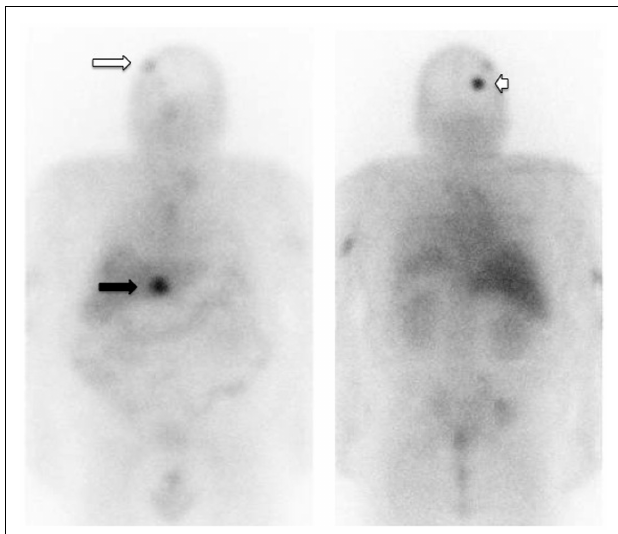
FIGURE 2 | Immunoscintigraphy (anterior and posterior views) recorded in a patient with metastatic medullary thyroid carcinoma . This patient was injected with the anti-CEA hMN14x734 bispecific antibody and a therapeutic activity of 131I-di-DTPA-indium.The immunoscintigraphy recorded 4days after hapten injection showed a good tumor uptake in liver (black arrow), bone (white arrow), and brain (white arrowhead)